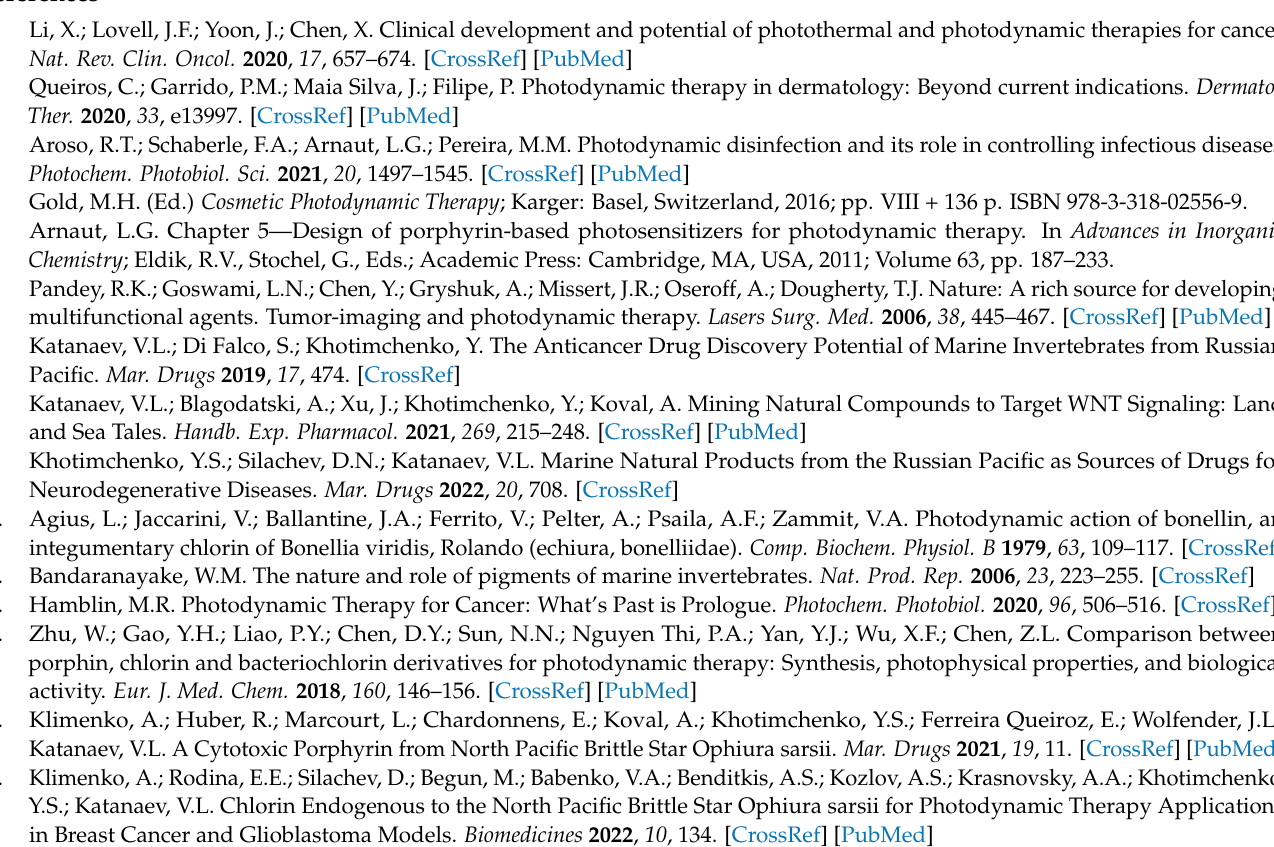
Feature-based Molecular Network of the EtOAc and MeOH (butanolic fraction) extracts of Ophiura sarsii ; Figure S34: UHPLC-PDA-ELSD analysis of extracts of Ophiura sarsii ; Figure S35: UV–Vis and ECD spectra of the isolated compounds; Figure S36: Fluorescence spectra of the isolated compounds; Figure S37: Phototoxicity of compounds 1 and 3 from MeOH and EtOAc